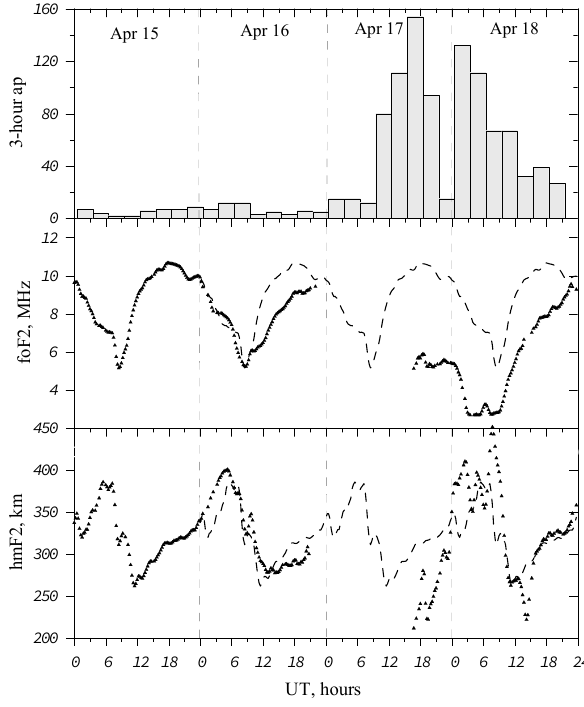
Fig. 4. Millstone Hill digisonde fo F2 and hm F2 diurnal variations Fig. 4. for 15–18 April 2002. Note that hm F2 are below median values for the day of Q-disturbance on 16 April. Low daytime hm values on 17–18 April correspond to the height of F1-layer maximum (G- conditions). Observed 3-h a p indices are given in the top